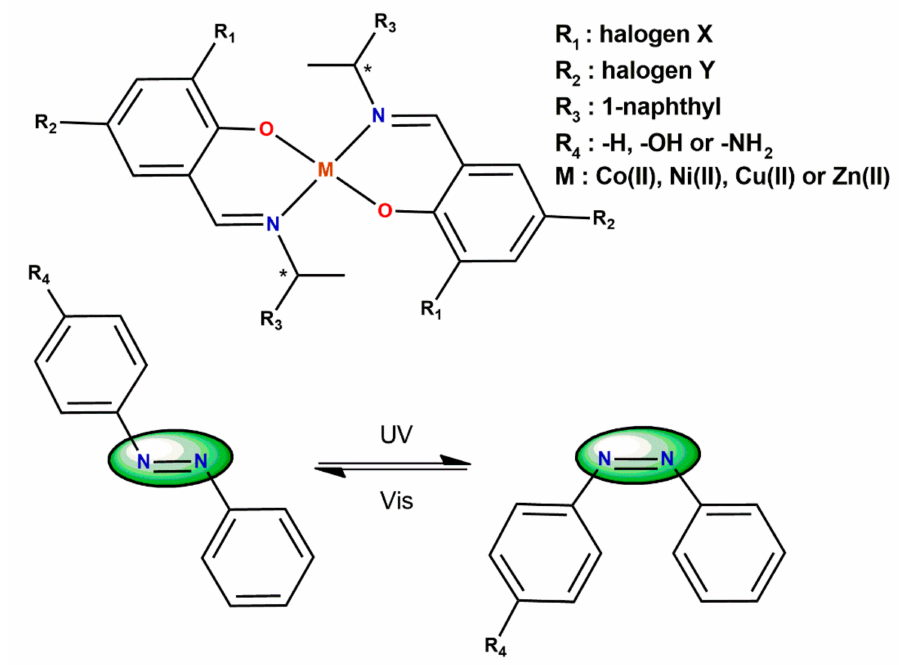
Figure 11. Structures of coordination compounds used by Akitsu and Itoh [67,68] for photoisomeriza- tion of azobenzene compounds induced by UV and visible light irradiation (* denotes an asymmetric carbon